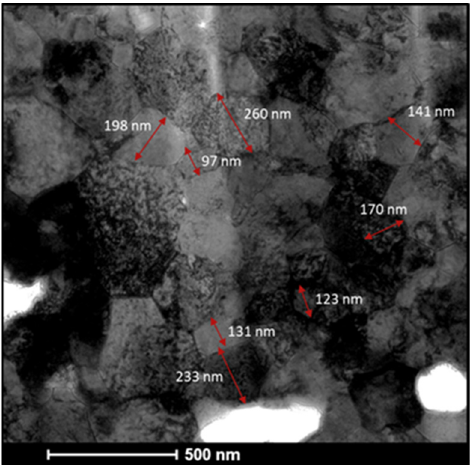
Figure 7. TEM micrograph of W 80 Al 20 powders annealed at 900 °C ( Θ ≈ 0.8) for 12 h.